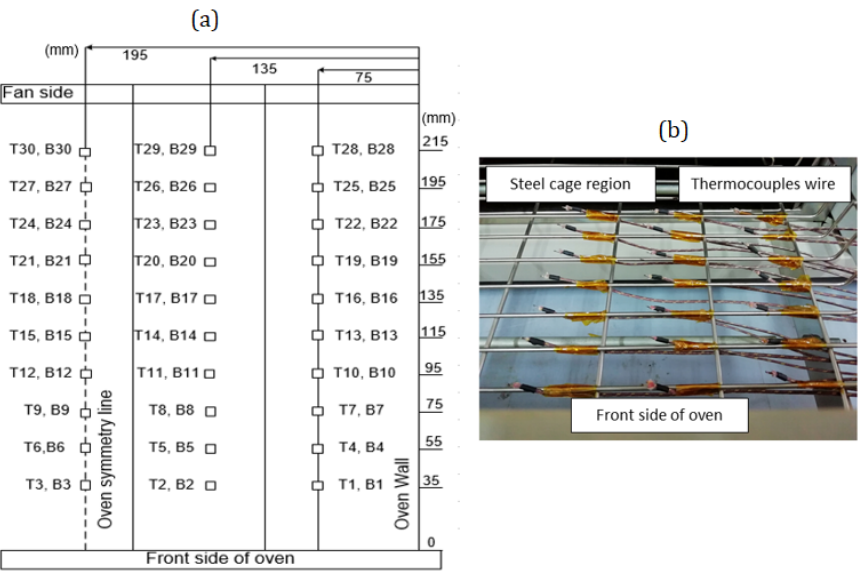
Figure 6. ( a ) Layout of the placement locations of the thermocouple in the oven steel cage region and ( b ) its actual image.